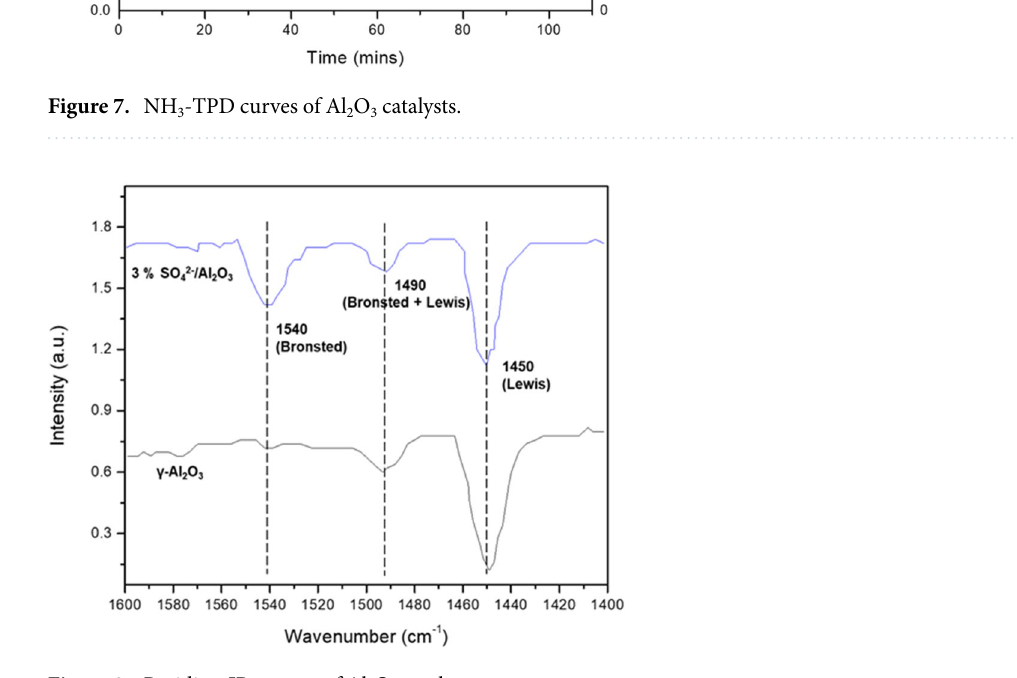
Figure 8. Pyridine-IR spectra of Al 2 O 3